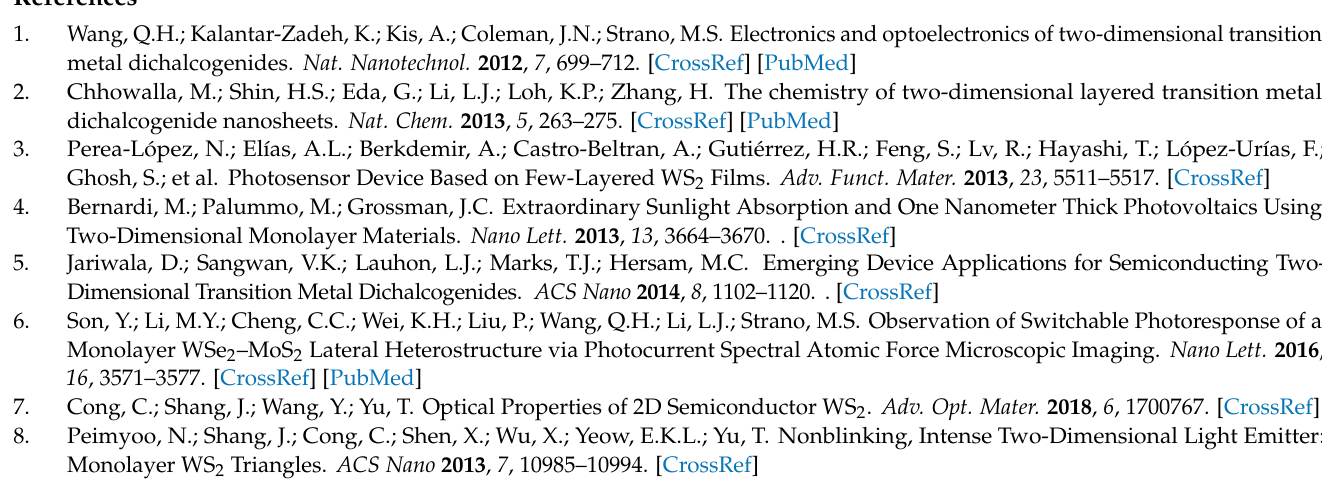
supported (red trace)